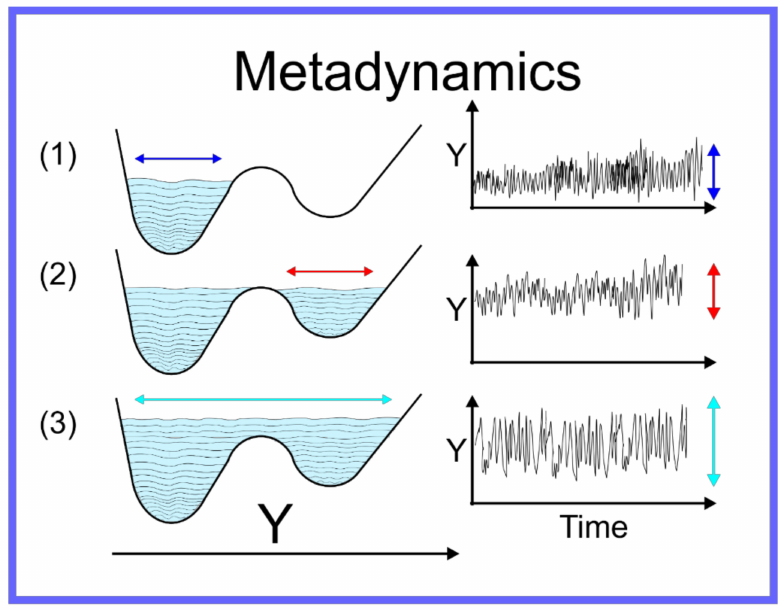
Figure 4. Schematic representation of